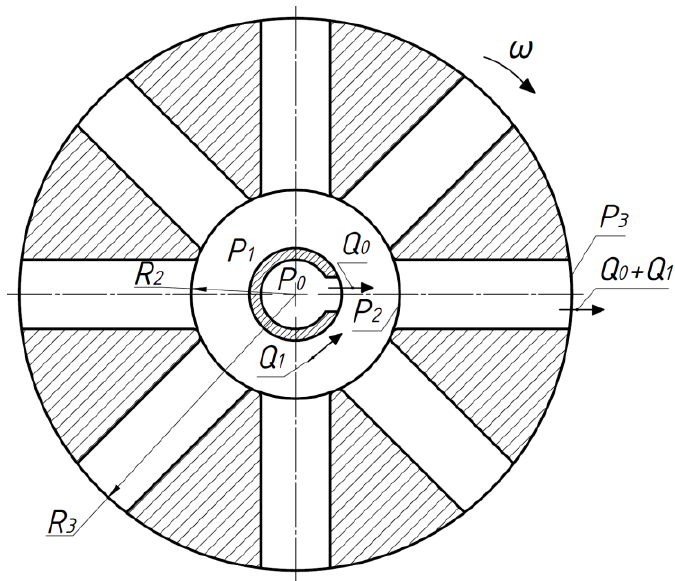
Figure 7. Computational scheme of the jet apparatus (variant with a rotating mixing chamber). Source: authors’ development.